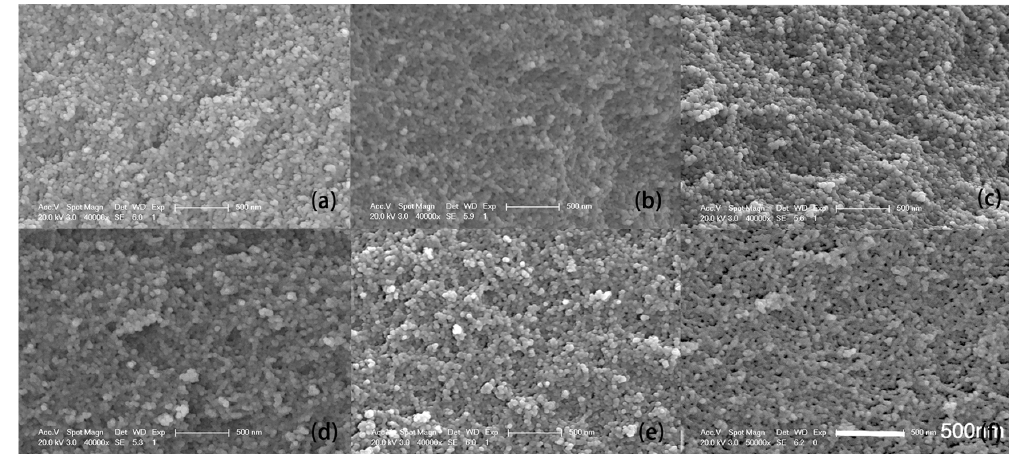
Figure 4. The SEM picture of the: ( a ) Pure SiO 2 aerogel and composition-gradient Fe 2 O 3 /SiO 2 composite aerogel at different positions: ( b ) A; ( c ) B; ( d ) C; ( e ) D; ( f ) E.